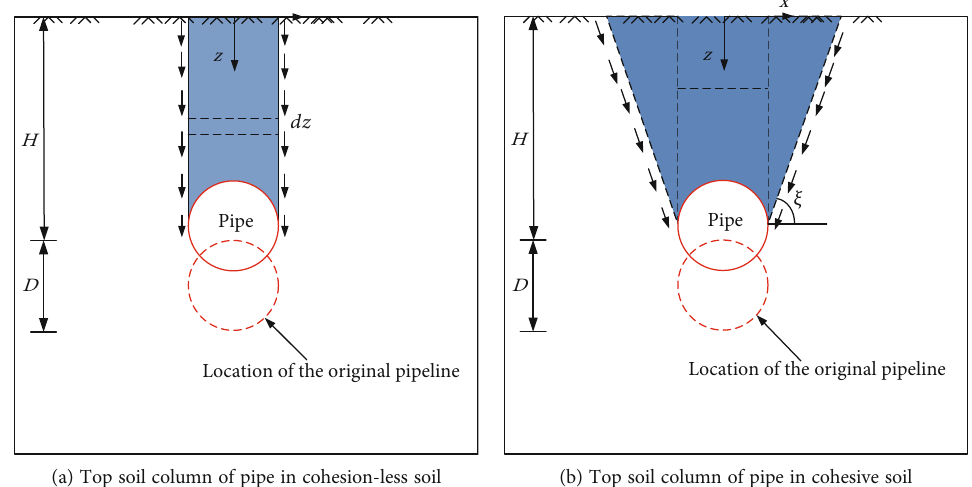
Figure 13: Shear plane in sol column at the top of